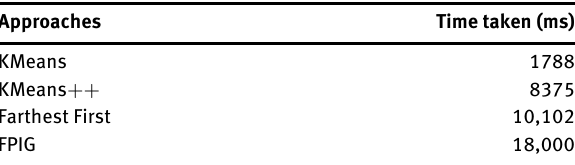
Table 7: Time Taken to Accomplish the Methods. Approaches Time taken (ms) KMeans KMeans ++ Farthest First